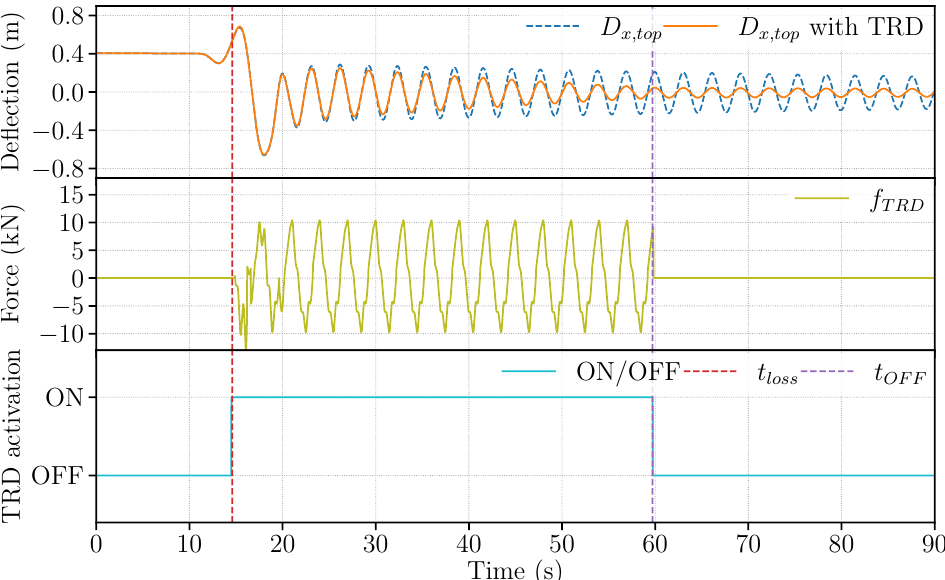
Figure A4. Tower-top fore-aft deflection and status of TRD in EOG with grid loss at V rate (the time dependency is omitted in